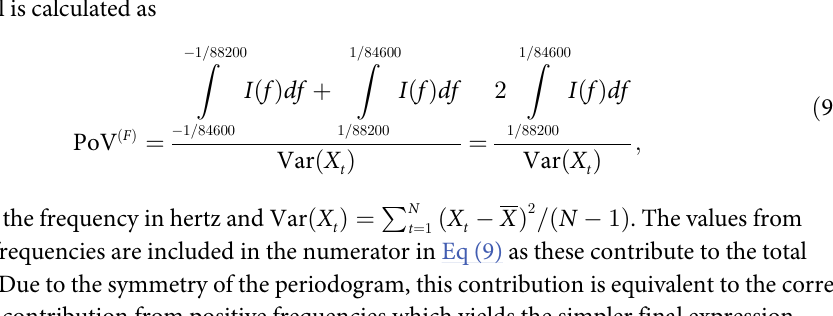
ffiffiffiffiffiffiffi p (cid:0) 1 represents the imaginary unit and | � | denotes